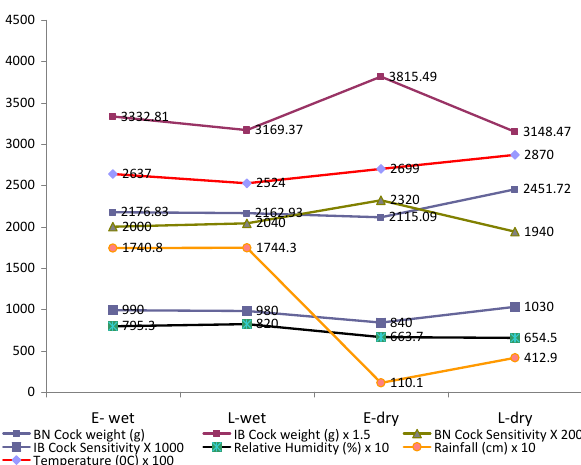
Figure 1. Graphs of cock weight and sensitivity indices for Bovan Figure 1: Graphs of Cock Weight and Sensitivity Indices for Bovan Nera and Isa Brown 3 Nera and ISA Brown genotypes across seasons overlaid with tem- genotypes across seasons overlaid with temperature, rainfall and humidity 4 perature, rainfall and humidity parameters. 5 6 4 Discussion 7 The most optimal body weight for reproduction was obtained by BN and IB in Late-wet and 8 Early-wet seasons respectively, indicating that IB genotype probably required slightly cooler 9 environment with lower humidity, with more sunshine hours, higher wind speed and higher 10 temperature (79.53%, 8.95 hours, 2.78 km/hr and 26.37 o C) than BN genotype (82.00%, 6.17 11 hours, 2.1 km/hr and 25.24 o C) for optimum performance. Table 2 also revealed superior 12 performance of IB over BN genotype within seasons in the region. 13 Results also showed that not all sensitivity indices were consistent in magnitude with 14 reproduction (Table 3). In contrast to this general finding, all genotypic sensitivity indices 15